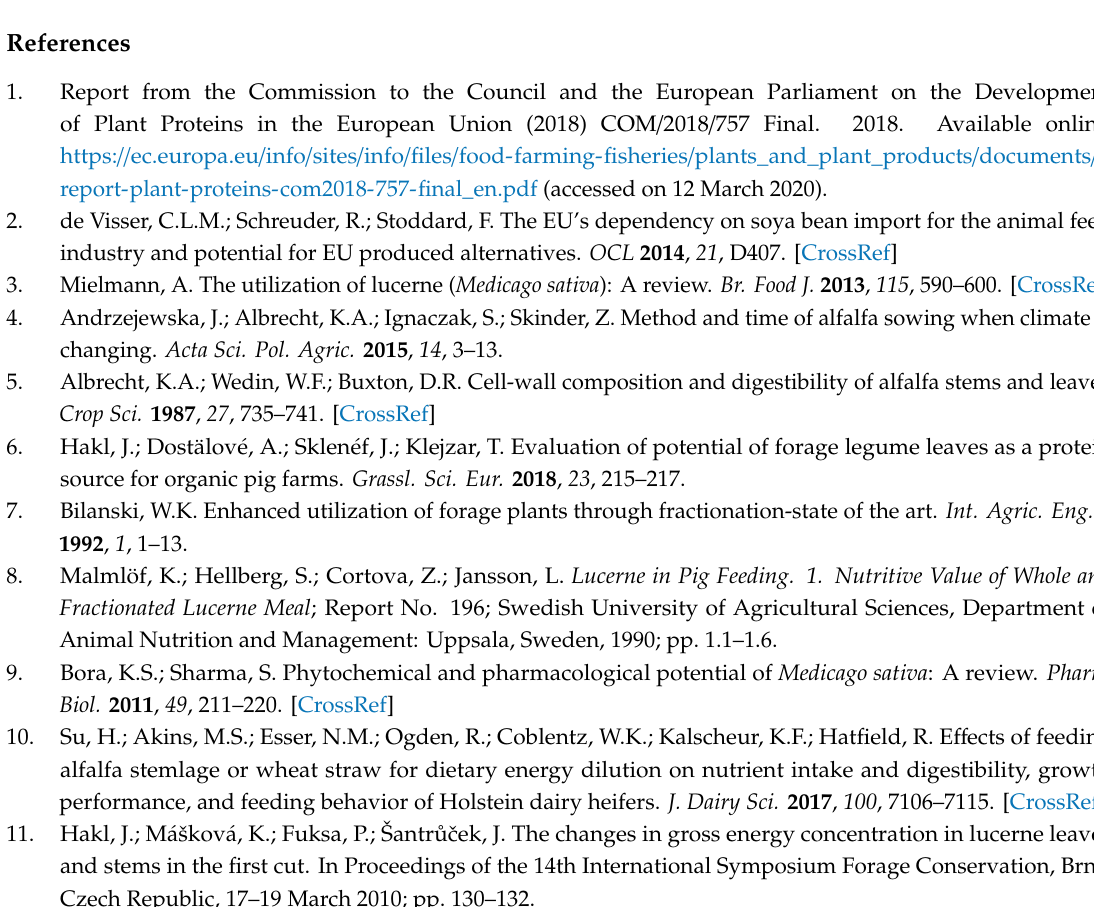
Figure A1. Diagram of modifications to flail chopper drum–original ( A ) and modified ( B ); (1) rows with knives, (2) knife, (3) support, (3 (cid:48) ) inverted support and (4)